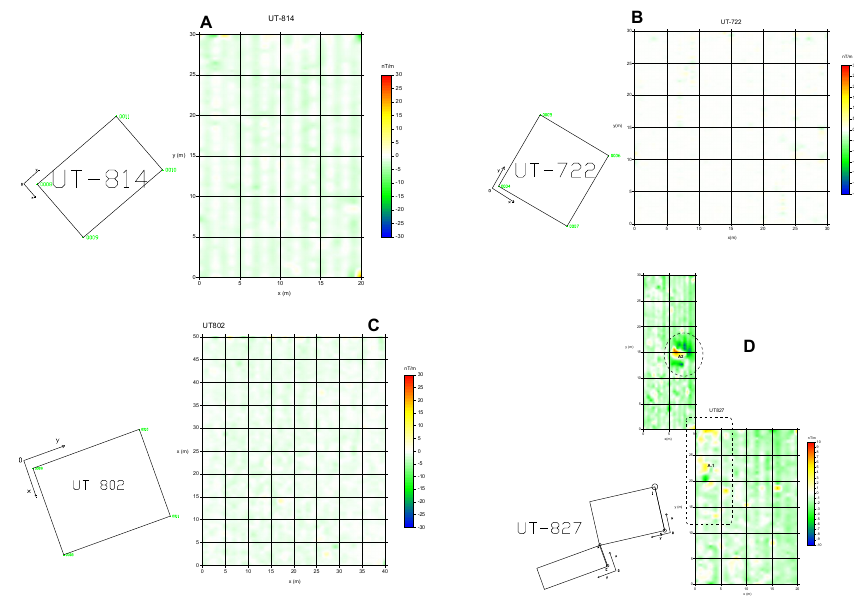
Fig. 2. Magnetic maps and simplified acquisition schemes carried out in the “Madonna della Valle”